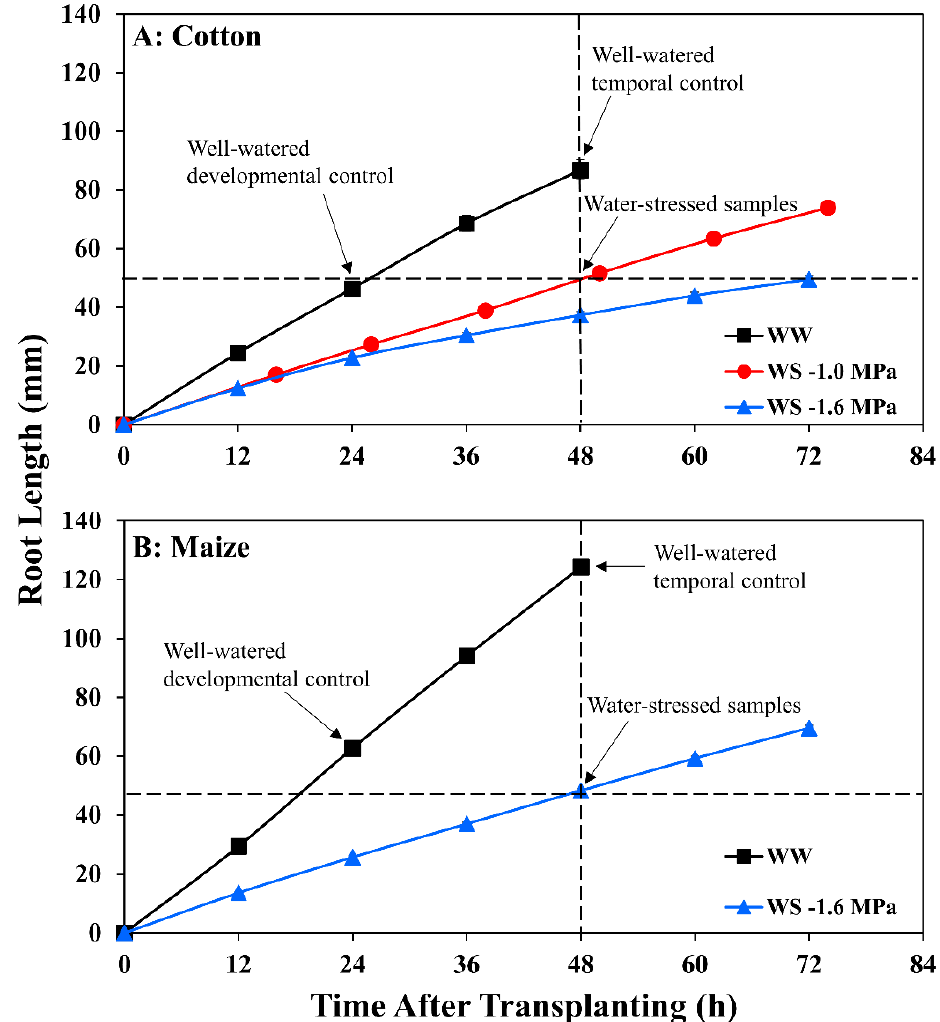
Figure 1. Time course of primary root length for ( A ) cotton and ( B ) maize seedlings after transplanting to well-watered (WW) or water-stressed (WS) conditions. In the water stress treatments, vermiculite water potentials were − 1.0 MPa (cotton) and − 1.6 MPa (cotton and maize). Data are the means ± SE of 32–48 seedlings. Primary root elongation rates were calculated from slopes of root length increase after 24 h when elongation was steady in all treatments. Arrows indicate times at which root samples were collected for metabolomic analyses in the water-stressed treatments and in the well-watered developmental control (approximately the same length as the water-stressed roots) and temporal control (same age as the water-stressed roots).